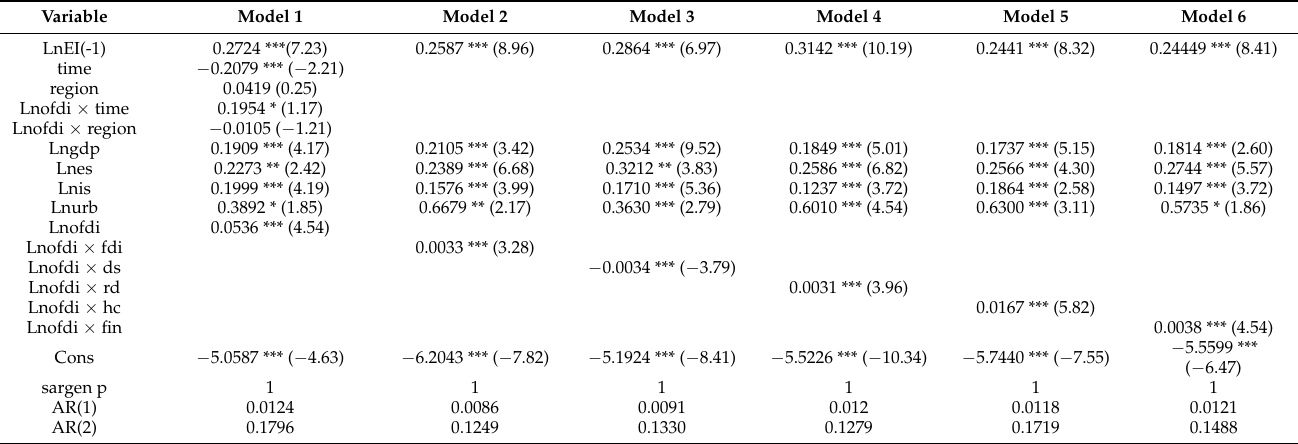
Table 11. Impact of China’s OFDI reverse technology spillover effect on the energy efficiency of the home